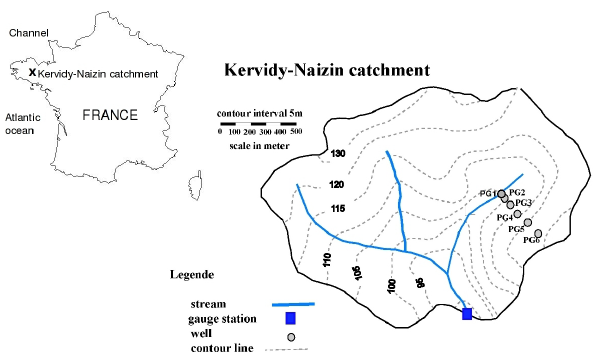
Fig. 1. Kervidy-Naizin catchment (5km 2 , Western France). Location of the study transect including 6 wells (PG1 to